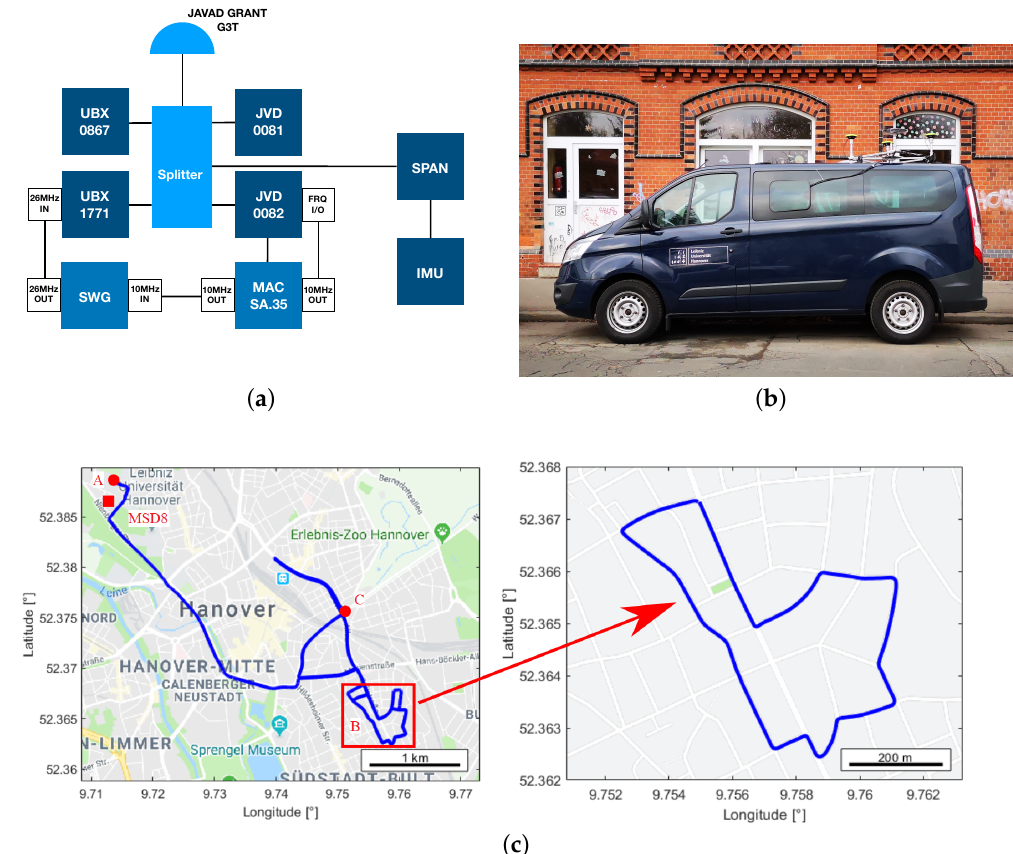
Figure 1. Kinematic experiment in Hannover. ( a ) Measurement setup: two JVD and two u-blox (UBX) receivers connected via a GNSS splitter to a geodetic antenna. One of each receiver types is connected to an atomic clock (MAC SA.35), SWG refers to signal wave generator and a Novatel SPAN receiver was logging inertial measurement unit (IMU) data. ( b ) Vehicle used during the experiment. ( c ) Measurement route. For details of the marked points, cf. Table 1. Map presentation taken from